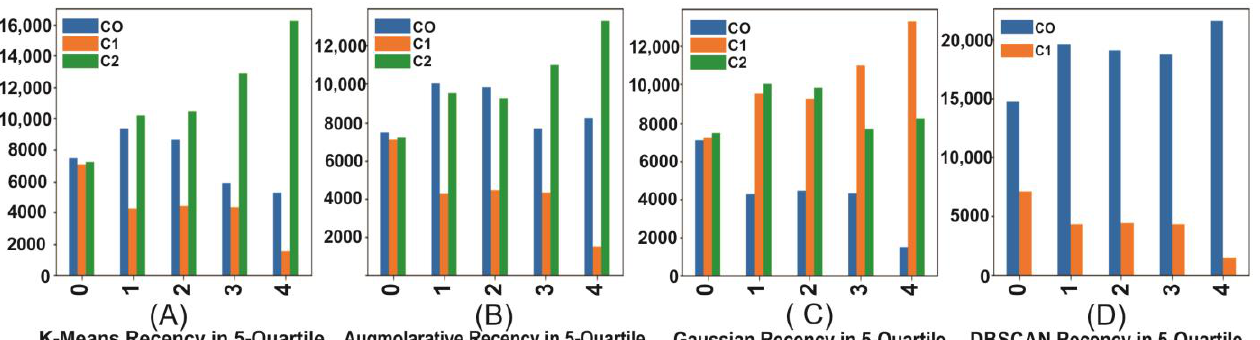
Figure 5. Recency distribution on a 5-quintiles/grades scale for different clusters and algorithms.